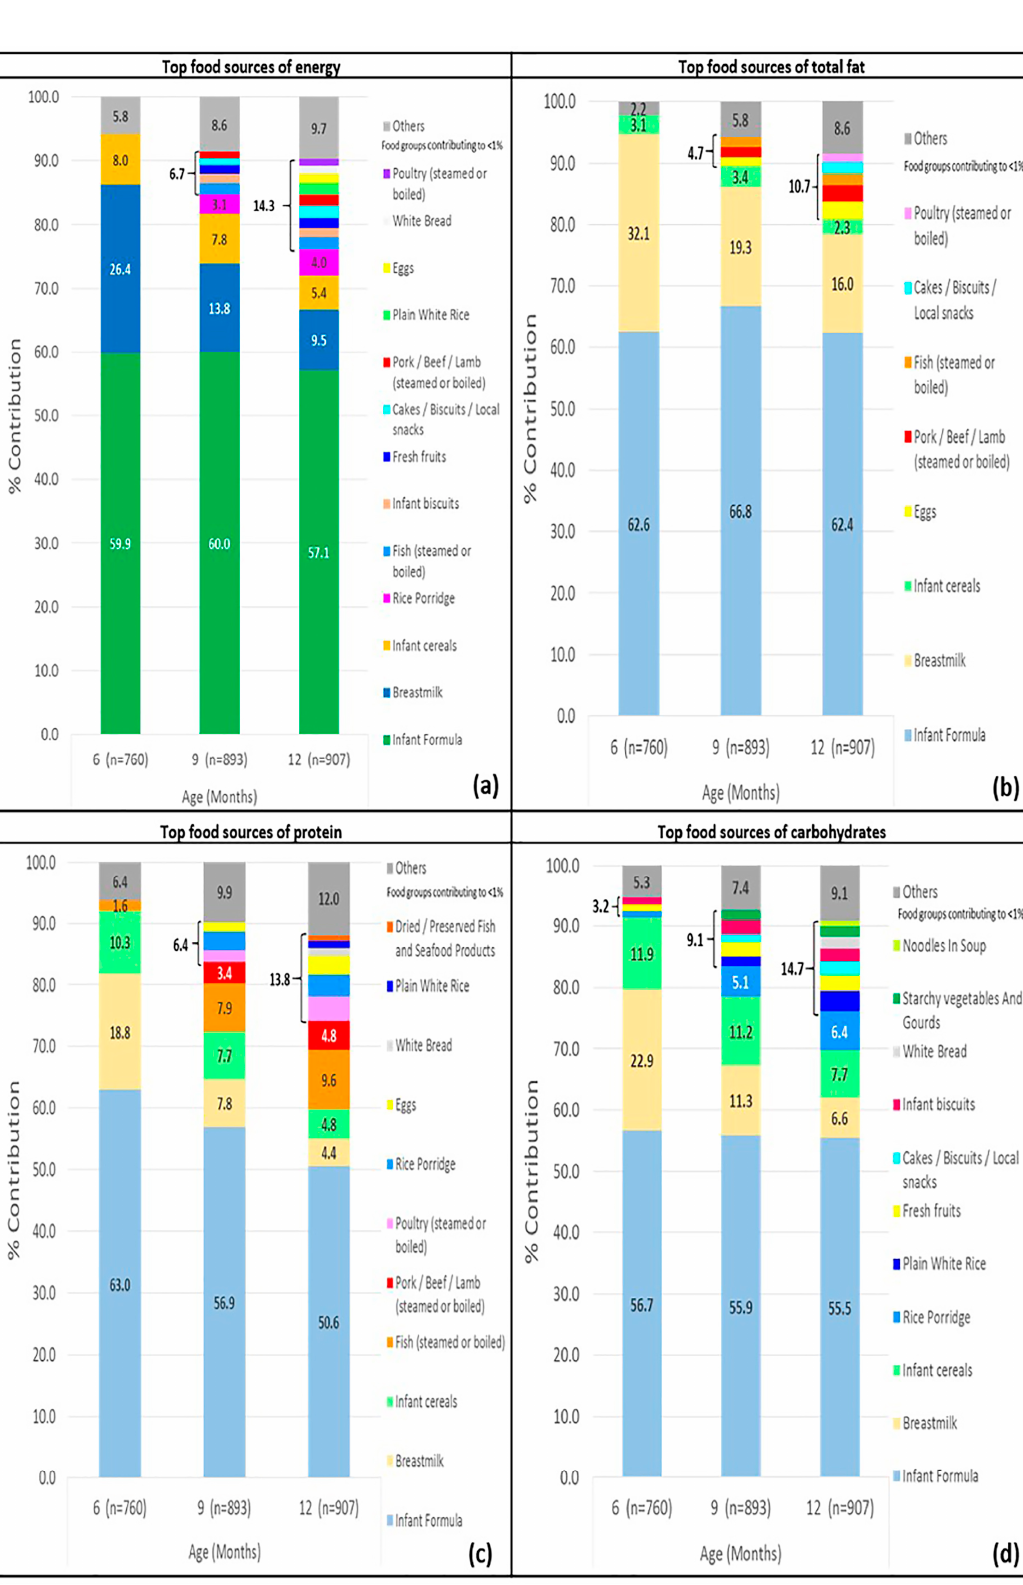
Figure 1. Cross ‐ sectional analyses of top food sources of ( a ) energy, ( b ) total fat, ( c ) protein and ( d ) carbohydrate of Growing Up in Singapore Towards healthy Outcomes (GUSTO) infants at 6, 9 and 12 months of age.